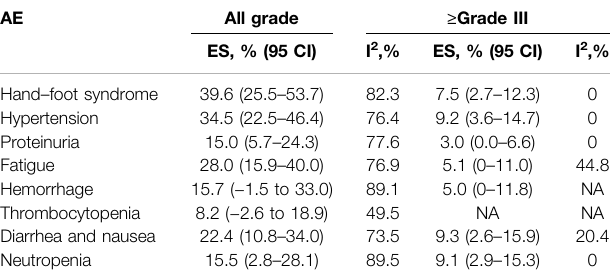
TABLE 3 | Adverse events of the studies included in the